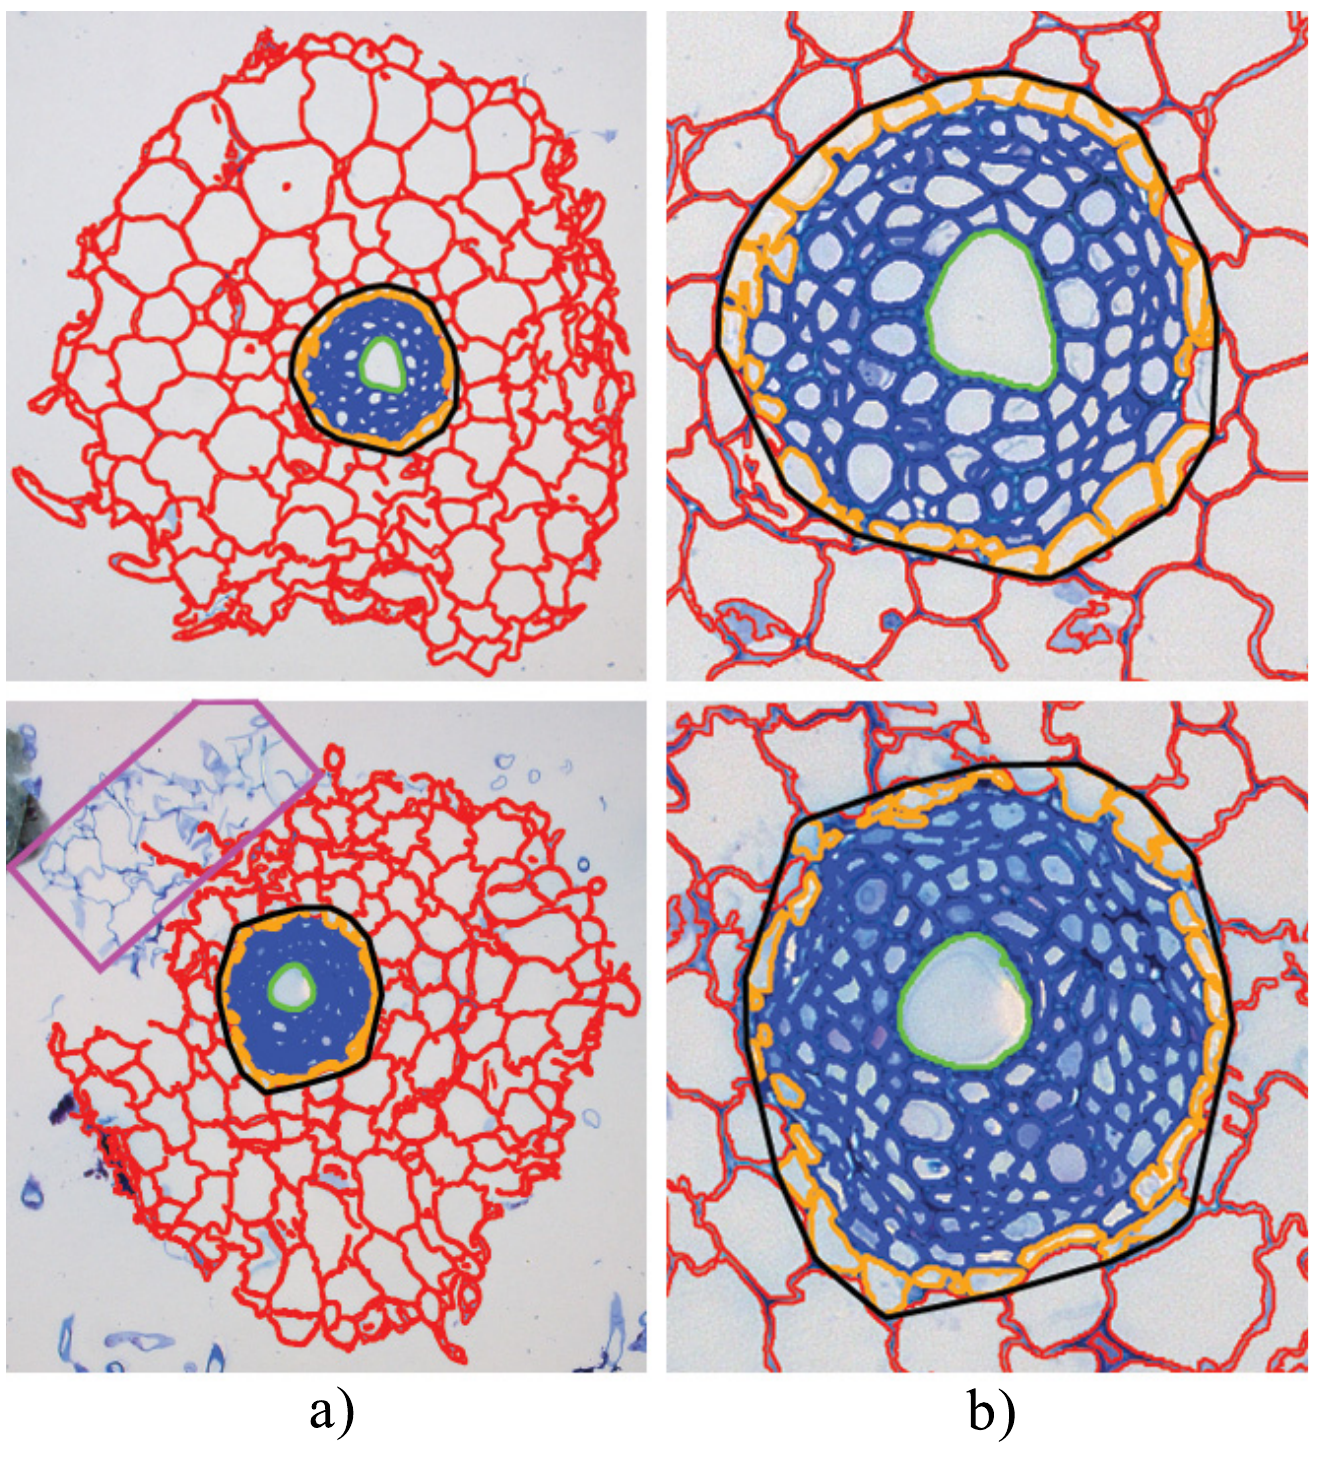
Fig 9. Sample results from the RootAnalyzer algorithm. (a) the entire root section analysed. The magenta rectangle in the bottom image denotes a small piece of segregated root that the algorithm has failed to capture. (b) zoomed versions of the respective stele regions highlighting cortical cells (red), epidermal cells (orange), stele cells (blue) and central metaxylems